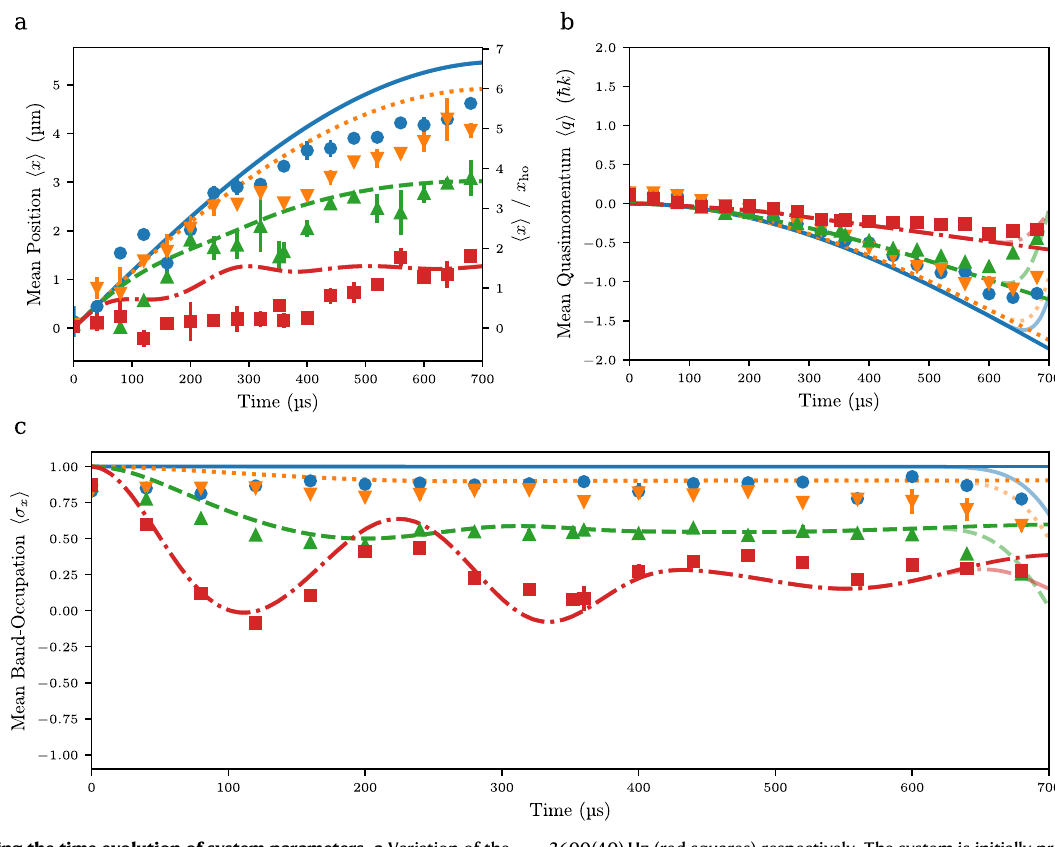
Fig. 3 | Revealing the time evolution of system parameters. a Variation of the 3600(40)Hz (red squares) respectively. The system is initially prepared in the momentum state | − 2 _ k 〉 . Theory results for the quantum Rabi and the periodic mean value of the atomic cloud position x h i on the interaction time. On the right quantum Rabi models are represented by non-transparent and semi-transparent hand scale, this quantity is given in units of the harmonic oscillator length x ho . lines,respectively. b Timeevolutionoftheobservedmeanatomicquasimomentum =2275 23 ð Þ Hz and a bosonic mode Experimental parameters were a coupling g (cid:7) (cid:8) (cid:7) (cid:8) 2 π for corresponding values of the qubit =346 ð 7 Þ Hz. Further, the used qubit spacing ω q was 0Hz (blue dots), and c the Bloch band occupation σ x frequency ω q 2 π 2 π spacing. The visible error bars denote the statistical 586(6)Hz (orange triangles), 1660(20)Hz (green upside-down triangles), and